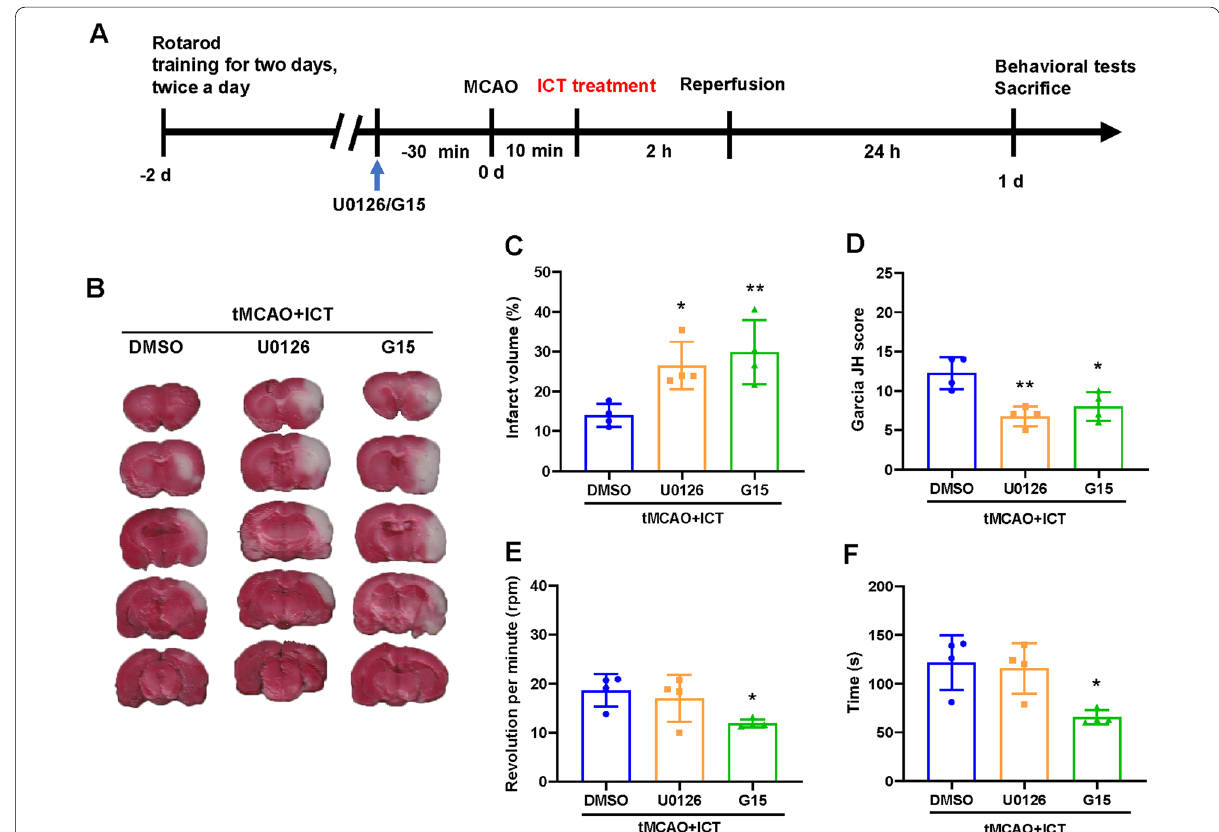
Fig. 5 G15 and U0126 reversed the neuroprotective effects of ICT in tMCAO rats. A The experimental timeline. B and C The cerebral infarct volume after tMCAO in brain tissue in the different groups were analyzed by TTC staining (n in rotarod test (n 4). F The time on rod in rotarod test (n = tMCAO